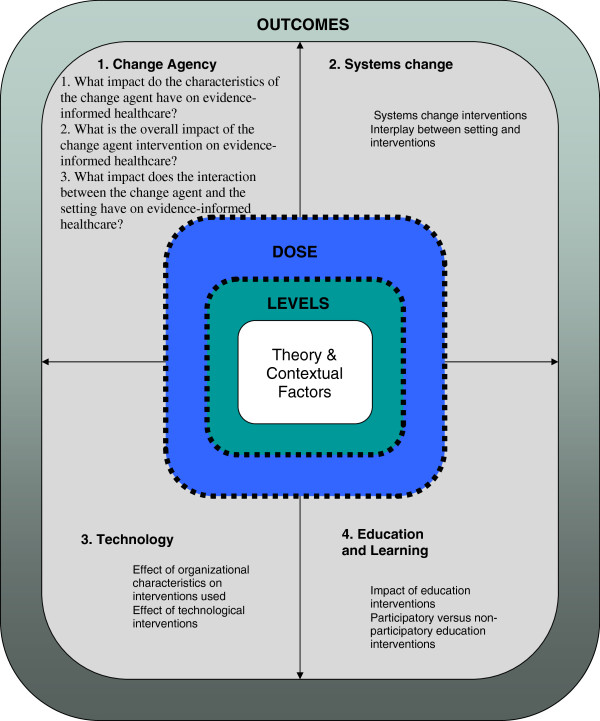
Review framework.